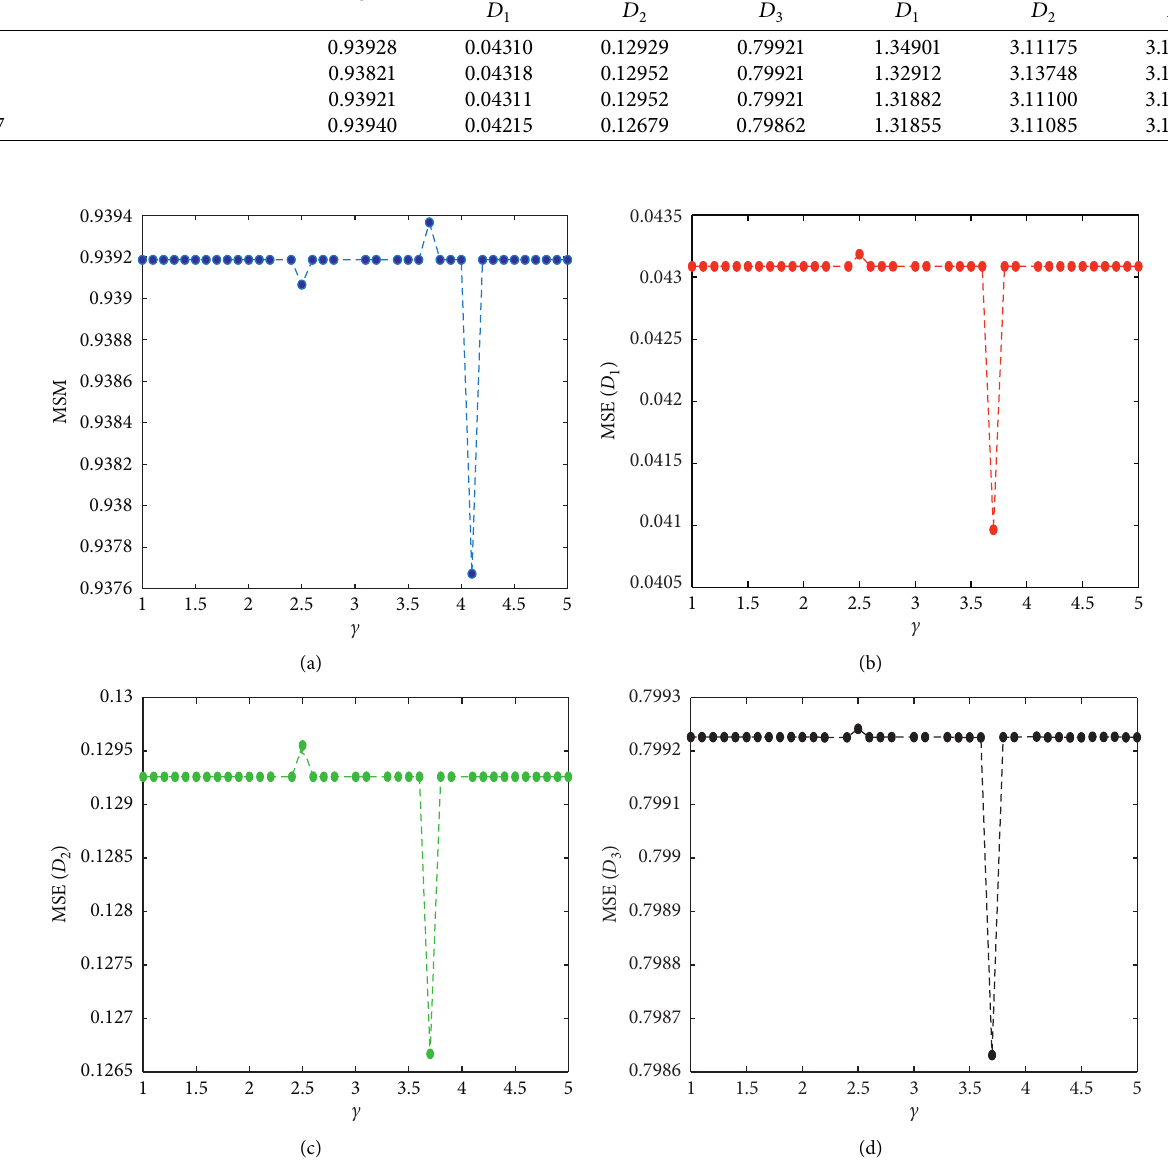
Figure 1: Goodness-of-fit measures for different values of c with three different distances D MSE index with distance D 1 , (c) MSE index with distance D